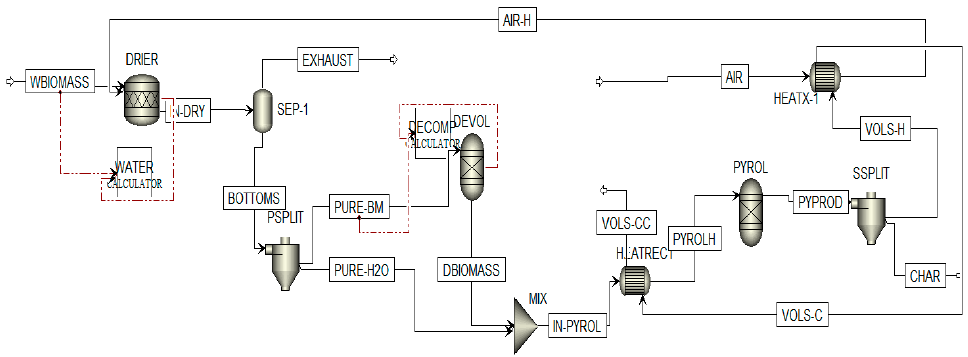
Figure 6. Heat recovery for pyrolysis (final model).